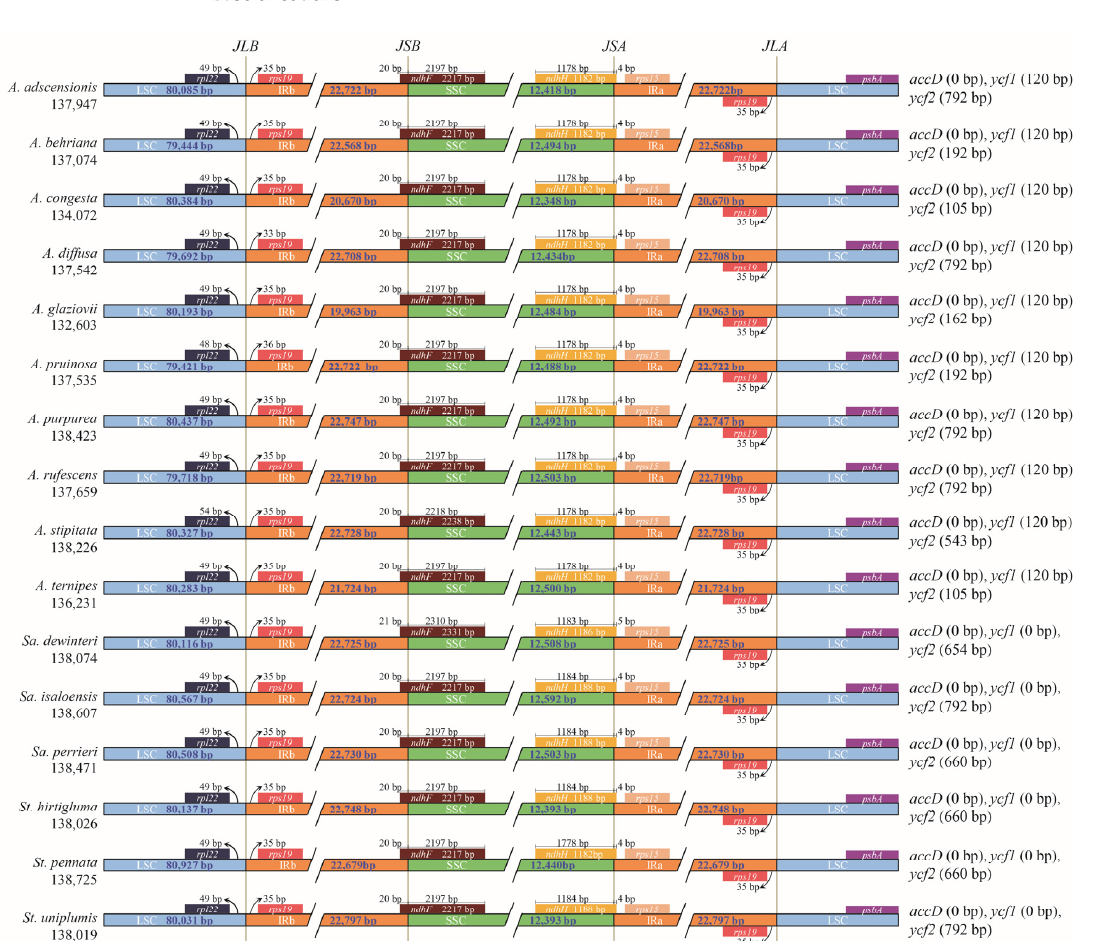
With reference to St. pennata , the structural differences among Aristidoideae plas- tomes were compared by mVISTA (Figure 5). The Aristida species had a similar structure, while the structures of Sartidia and Stipagrostis plastomes were more similar. For the four parts of the plastome, the SC region had a greater degree of variation than the IR region, and most variation occurred in the non-coding region. To compare the sequence divergence of Aristidoideae plastomes, the parsimonious information sites were counted for CDS and non-coding sequences. The percentage of parsim-info (Pi%) sites for CDS ranged from 0.196 ( ndh B) to 6.965 ( rpl 32), with an average value of 2.823 (Figure 6A). For non-coding sequences, the Pi% value varied from 0.185 ( rps 12 intron) to 10.563 ( rpl 32- trn L-UAG), and the mean value was 4.694 (Figure 6B). In the CDS, with Pi% ≥ 5 as the threshold value, four highly variable sequences ( mat K, ndh F,